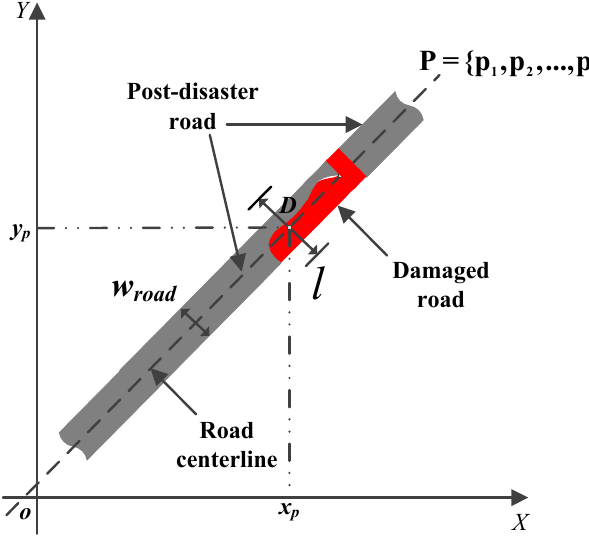
Figure 3. Schematic diagram of post-disaster road extraction. P is a group of pixels located in the road centerline ( { , ,..., } P p p p  , n is the total number of pixels). l represents the 1 2 n searching line which moves along the road centerline and the length is D ( D ≥ w road ).